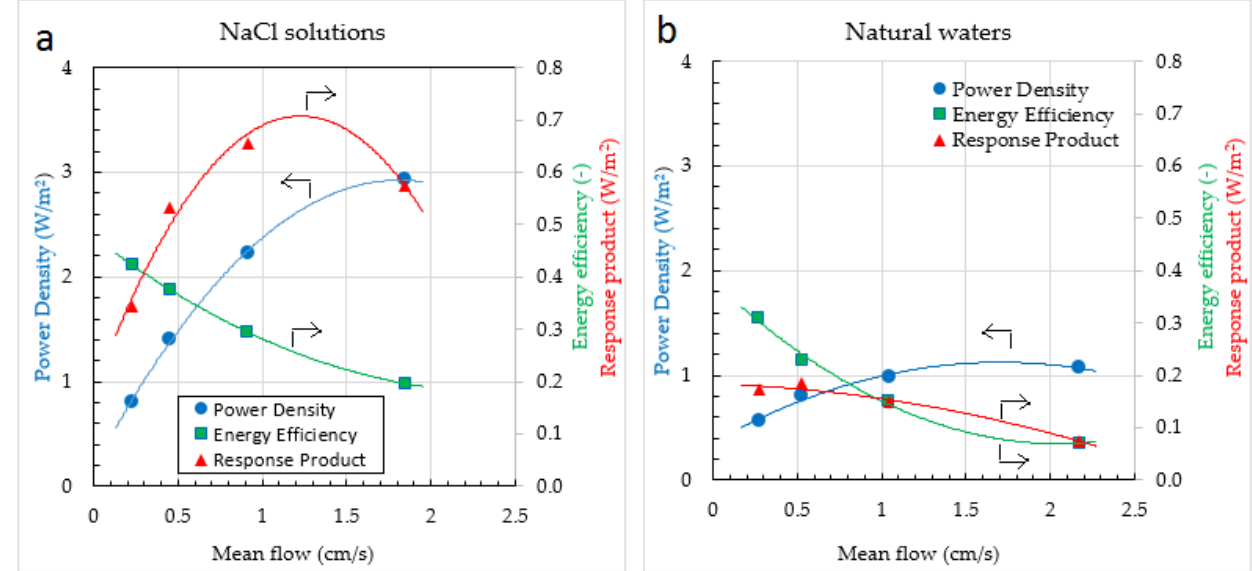
Figure 12. Power density, energy efficiency, and response product of a RED stack, fed with pure NaCl solutions ( a ) and fed with water from the Wadden Sea and the Lake IJssel ( b ). The stack consists of 10 cell pairs and is equipped with experimental membranes (Fujifilm, The Netherlands). Stack dimensions are 10 × 10 cm 2 and spacers are 115 µ m. Parabolic regression lines are added to the plots. Arrows in the figures refer to the corresponding axes.